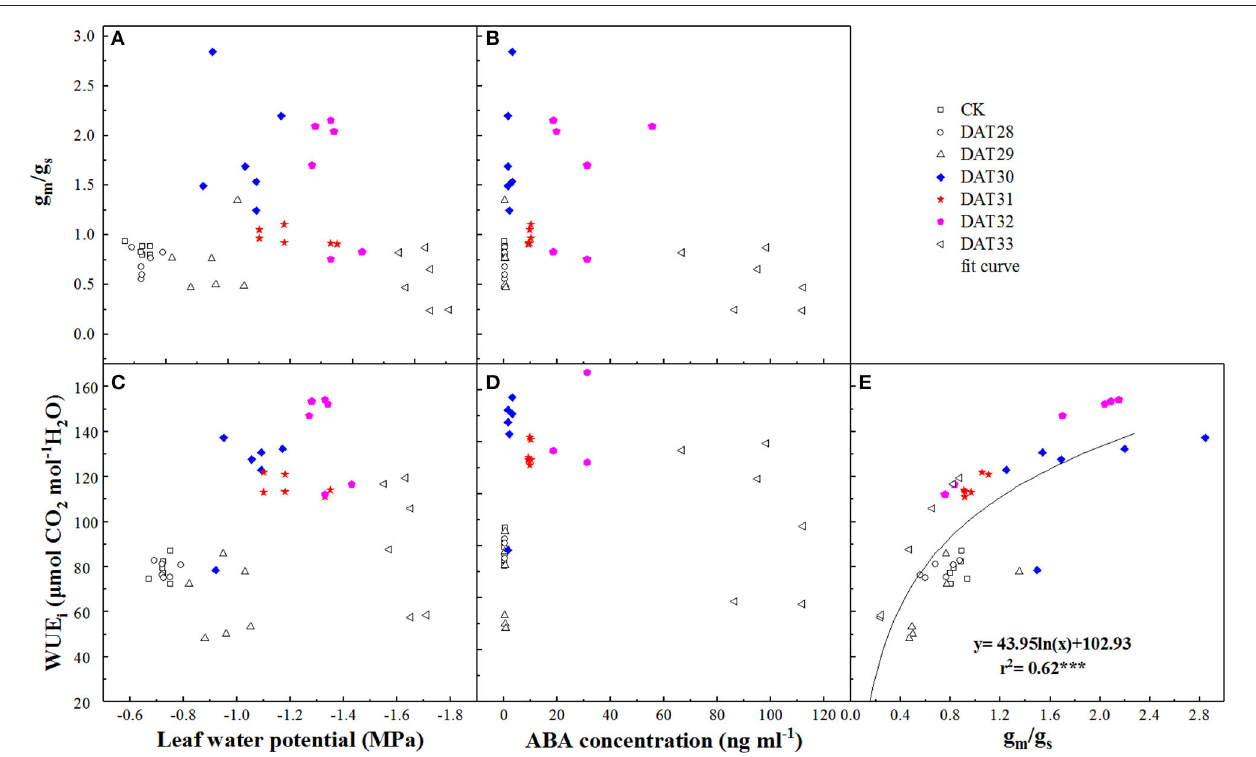
FIGURE 6 | Correlation between ratio of mesophyll conductance to stomatal conductance (g m /g s ) or intrinsic water use efficiency (WUE i ) and leaf water potential (A,C) or shoot sap ABA (B,D) under progressive drought. The relationship between g m /g s and WUE i was presented with a non-linear regression at P < 0.001 level (E) . Colorful labels indicated significant difference between the well-watered (CK) and drought treatments at P < 0.01